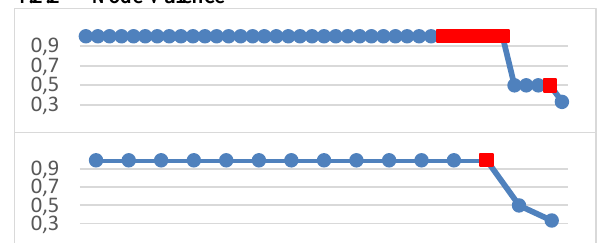
Figure 3: Node Valence Scores for a simple (top) and a complex (bottom) region The scores of Node Valence Matching can be seen in Figure